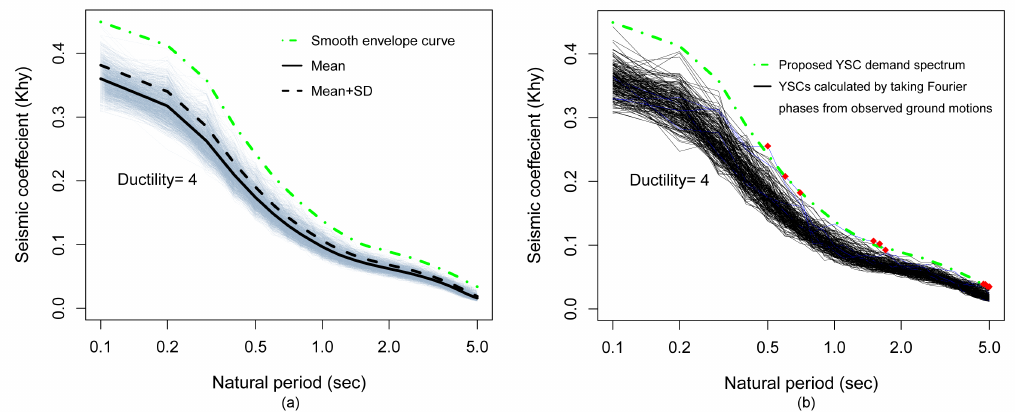
Figure 13. Smoothed envelope curve and the fluctuation of YSC demand spectra obtained by ( a ) 1000 DRSCEMs simulated by the modified fBm process and ( b ) 500 DRSCEMs simulated by observed earthquake motions